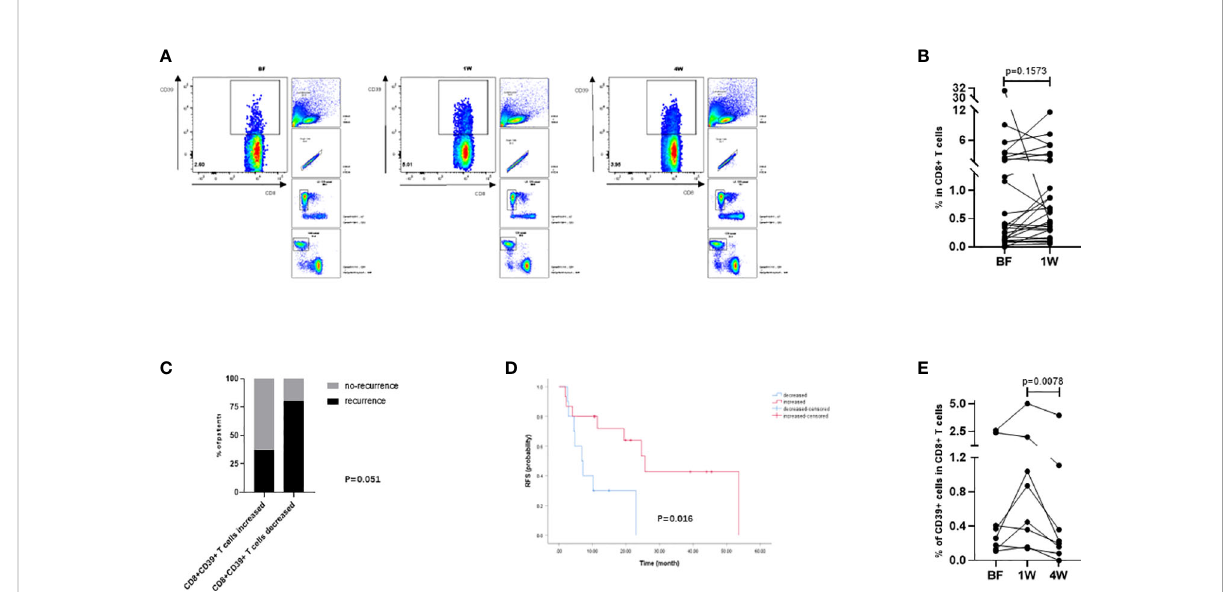
FIGURE 5 Analysis of tumor-speci fi c T cells in peripheral circulation de fi ned by CD8+CD39+ T cells. (A) The gating strategy of CD8+CD39+ T cells in fl owcytometry analysis. (B) The compared BF: 1W matching analysis of the CD8+CD39+ T cells (n=26). (C) The changes of CD8+CD39+ T cells at 1W were compared with those at BF according to the prognosis of patients one year after ablation (n=26). (D) Kaplan-Meier curves indicating the relationship between month after ablation and HCC recurrence-free survival rate were grouped by the changes of CD8+CD39+ T cells from BF to 1W (n=26). (E) The BF: 1W: 4W matching analysis of the CD8+CD39+ T cells (n=8). Values were compared by paired non-parametric